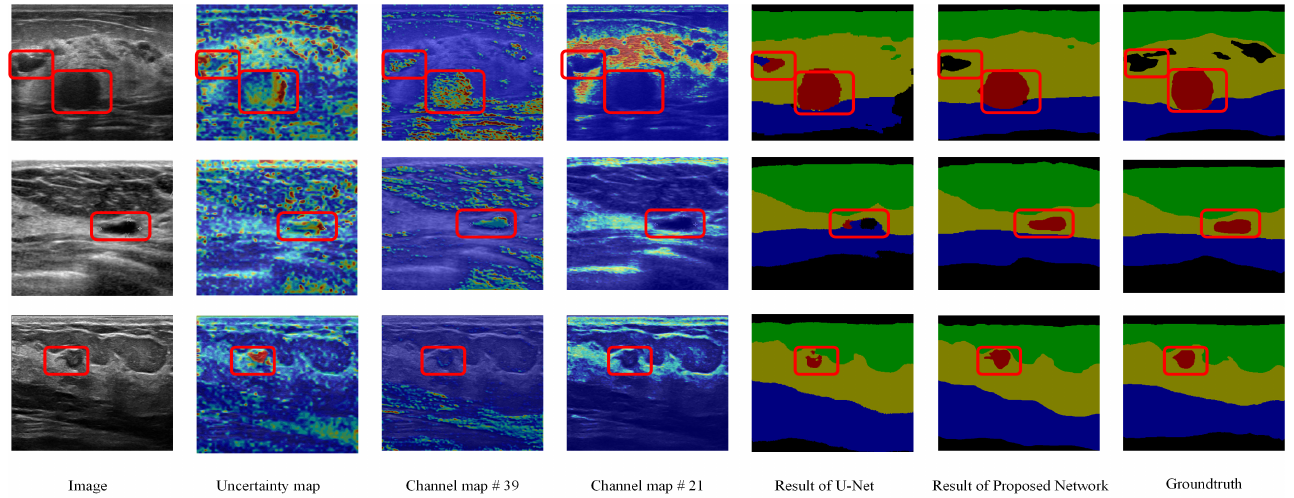
Figure 10. Visualization results of fuzzy blocks on the multi-object dataset. For each row, we show an input image, an uncertainty map from the SFB; red represents a high value and blue represents a low value in the heatmap. We also provide two channel maps from the outputs of the CFB, the results of the original U-Net and the proposed method, and the groundtruths. Green: fat layer, yellow: mammary layer, blue: muscle layer, red: tumor, and black: background. The red rectangles represent the mis-segmented regions by the baseline module or tumor